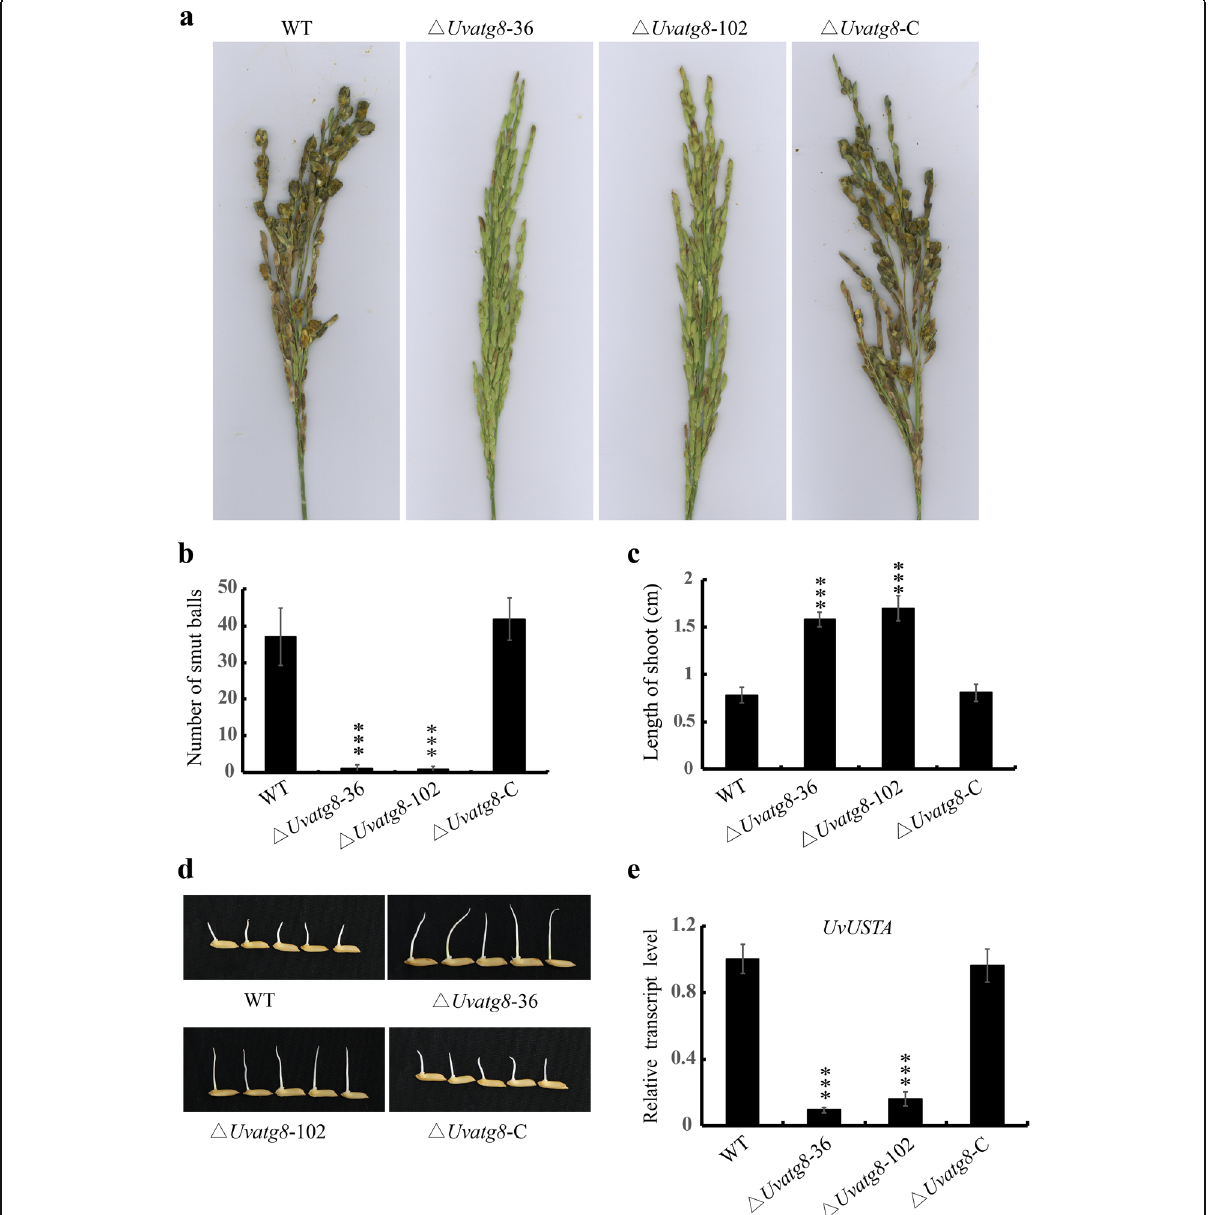
Fig. 6 Virulence assays of the Δ Uvatg8 mutants. a, Disease symptoms caused by the WT, Δ Uvatg8 , and Δ Uvatg8 -C strains on 21 d after inoculation. b, Statistical analysis results of the average number of false smut balls per spikelet. At least three independent biological experiments were performed with 30 inoculated panicles each time. c, Culture filtrates of the Δ Uvatg8 mutants displayed less inhibitory of rice seedling germination. The shoot lengths were measured and statistically analyzed after 7 d in 28 °C illumination incubators. d, The growths of the rice shoots of the indicated strains were treated with testing culture filtrates. More than 100 rice seeds were sterilized with 0.1% potassium permanganate, then shifted to 35 mL culture filtrates at 28 °C for 7 d. e, qRT-PCR analysis of the expression of UvUSTA in the WT, Δ Uvatg8 , and Δ Uvatg8 -C strains. β -tubulin gene was used as the endogenous reference gene. Three independent experiments ( n = 100) were carried out (mean ± SD). *** indicates p <